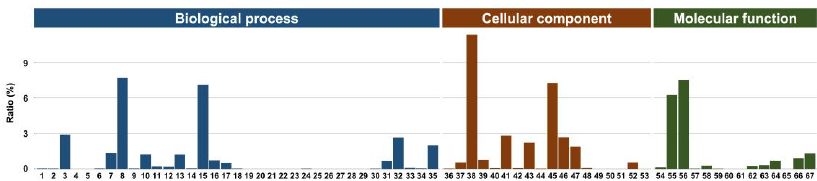
Figure 4. Bar diagram of unigenes assigned to 67 Gene Ontology (GO) categories. GO terms of bio- logical process: 1 behavior, 2 biological adhesion, 3 biological regulation, 4 carbon utilization, 5 cell killing, 6 cell proliferation, 7 cellular component organization or biogenesis, 8 cellular process, 9 detoxification, 10 developmental process, 11 growth, 12 immune system process, 13 localization, 14 locomotion, 15 metabolic process, 16 multicellular organismal process, 17 multi-organism process, 18 nitrogen utilization, 19 obsolete chloroplast ribulose bisphosphate carboxylase complex